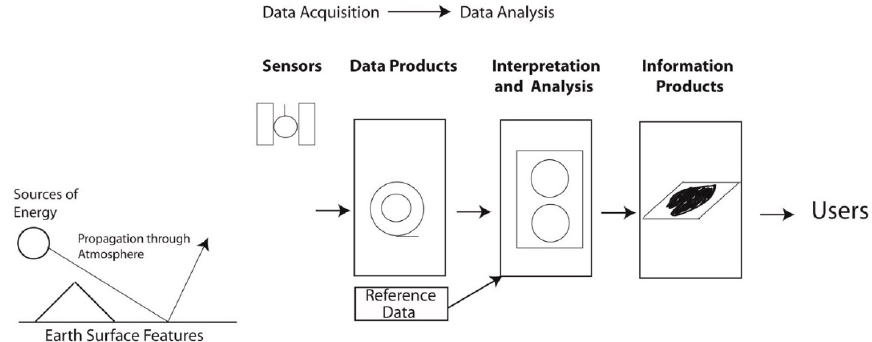
Figure 1. Generalized processes and elements in a remote sensing system [54].